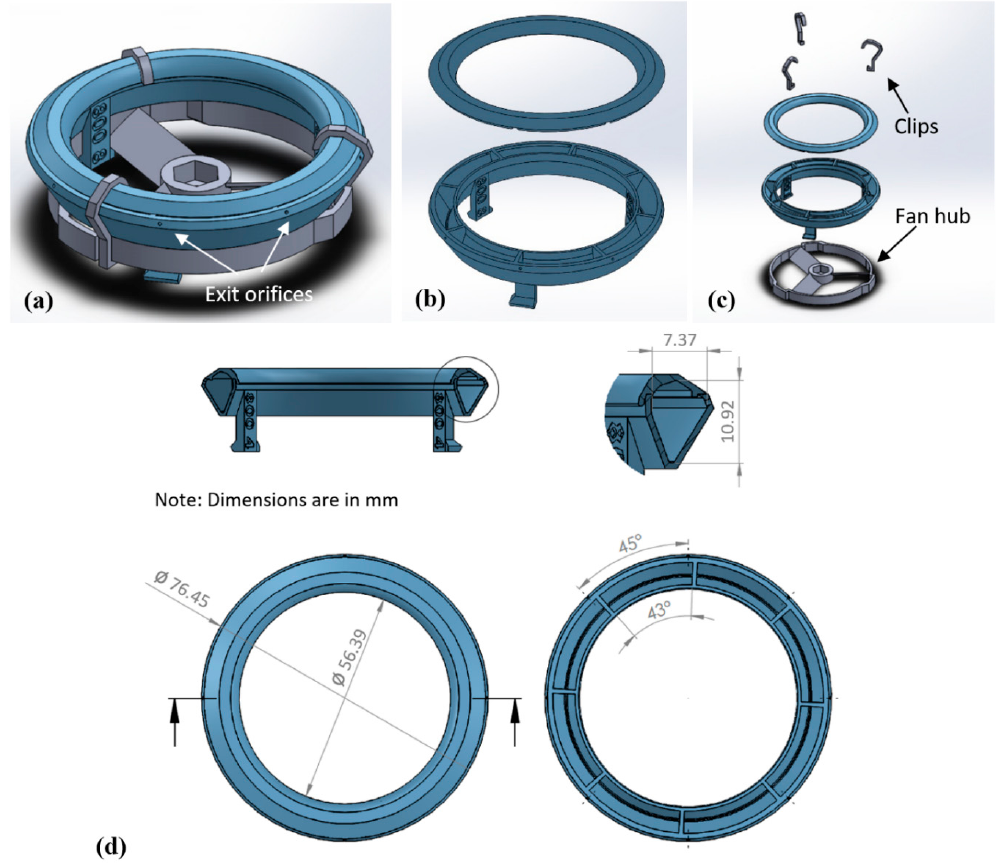
Figure 2. Spinneret design, showing: ( a ) the spinneret assembly; ( b ) clamshell design; ( c ) spinneret assembly exploded view; and ( d ) clamshell design in detail, including dimensions.